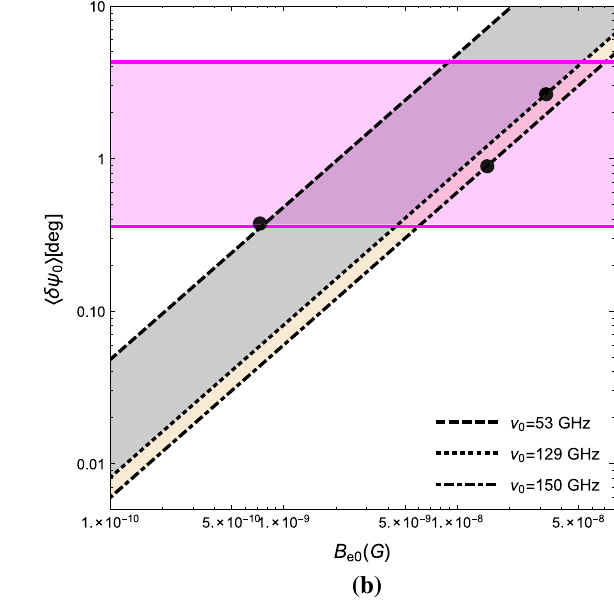
from the top is the constraint found by BICEP 1[37] at the frequency = 129 GHz where | δψ | = 2 . 77 ◦ . The third and fourth points from ν 0 0 the top are the constraint found by the QUaD collaboration [38] at the frequencies 100 GHz and 150 GHz where the constraint on δψ 0 are respectively | δψ 0 | = 1 . 89 ◦ and | δψ 0 | = 0 . 83 ◦ . The fifth point from the top is the constraint found by the WMAP9 collaboration [39] at the frequency ν 0 = 53 GHz where | δψ 0 | = 0 . 36 ◦ , see also Ref. [40] for a general discussion on the constraints on δψ 0 . In b the first point from the bottom correspond to the WMPA9 collaboration [39] constraint at ν = 53 GHz, the second point from the bottom correspond to the 0 QUaD constraint [38] at ν 0 = 150 GHz and the third one correspond to the BICEP 1[37] at ν 0 = 129